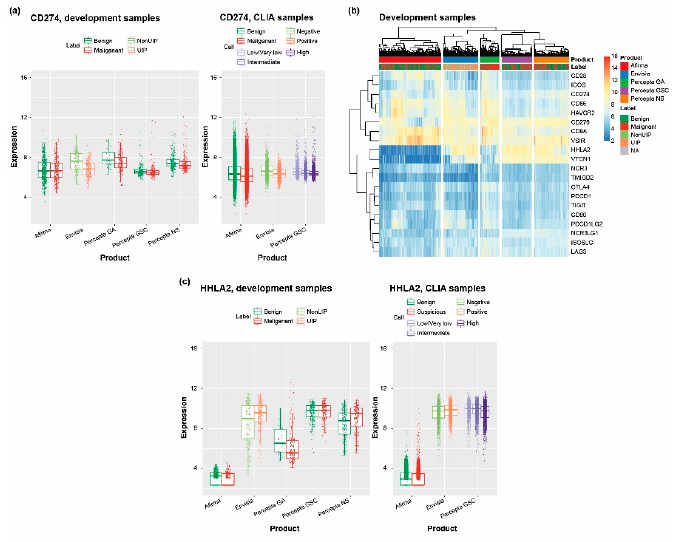
Figure 5. RNA and gene expression across samples used in the development of each test. ( a ) RNA expression of CD274 (PD-L1); ( b ) gene expression of potential drug targets (focusing on B7